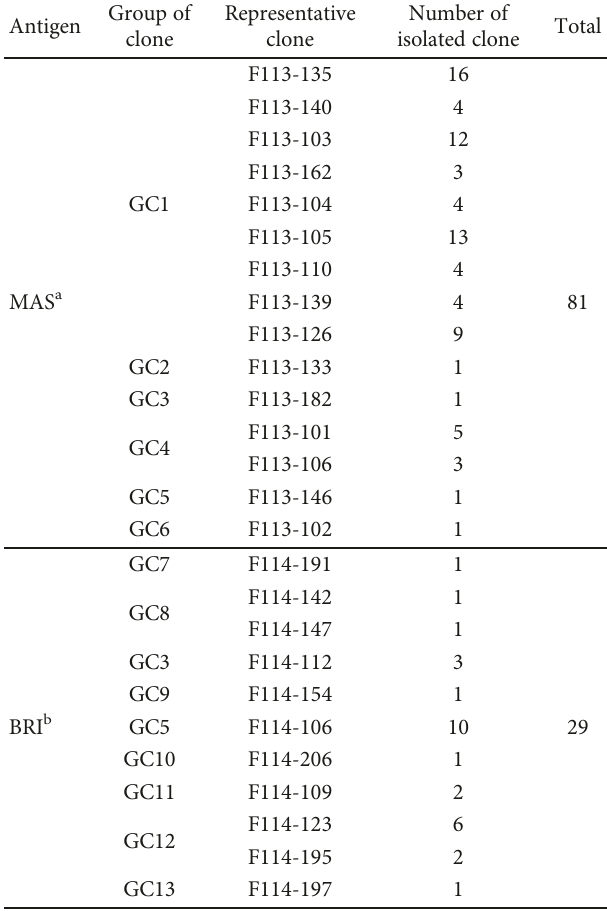
Table 1: Classi fi cation of isolated clones. Group Antigen